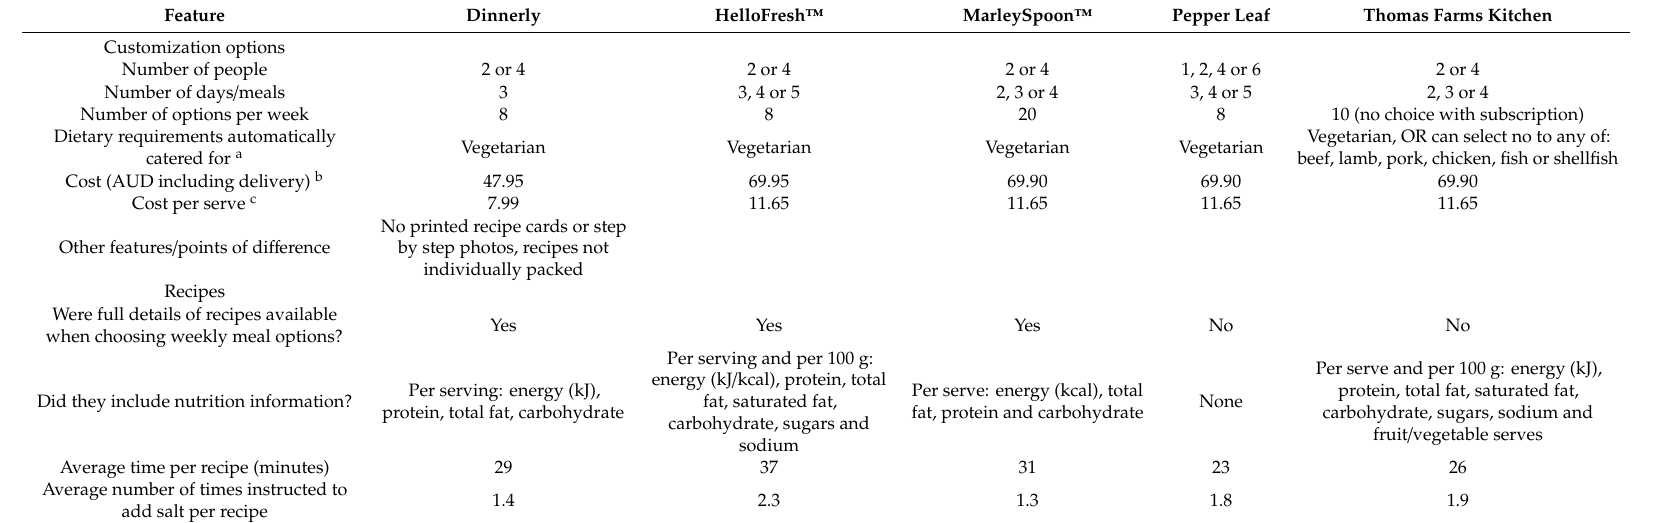
Table 1. Overview of the ordering options, costs and recipes characteristics of each of the five meal kit subscription